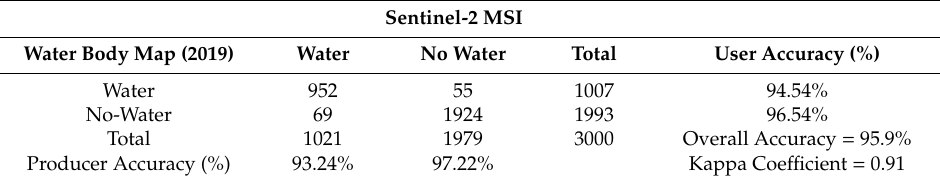
Table 1. The confusion matrix was employed for an accurate evaluation of this